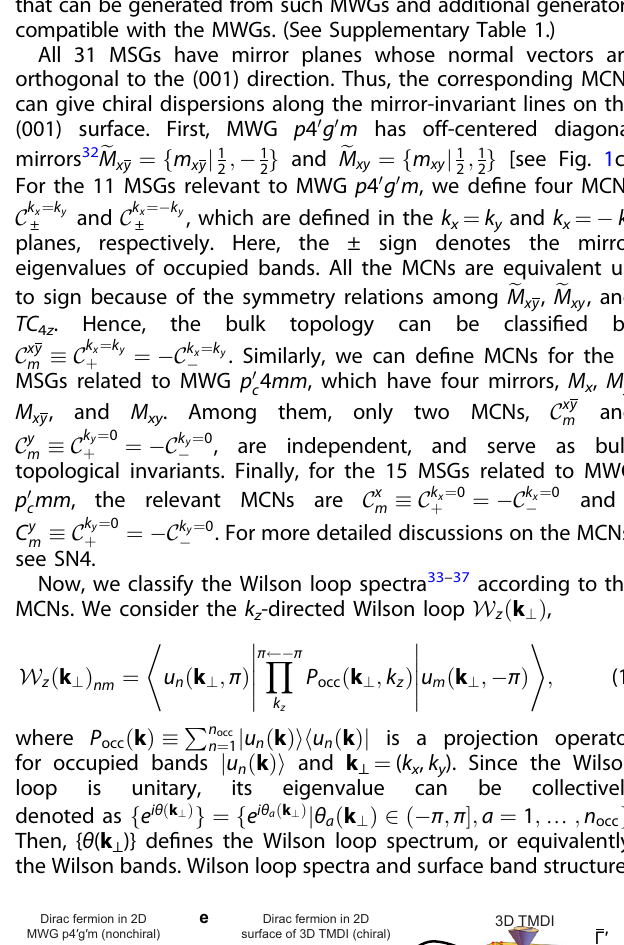
mm and b p 0 4 mm , c c